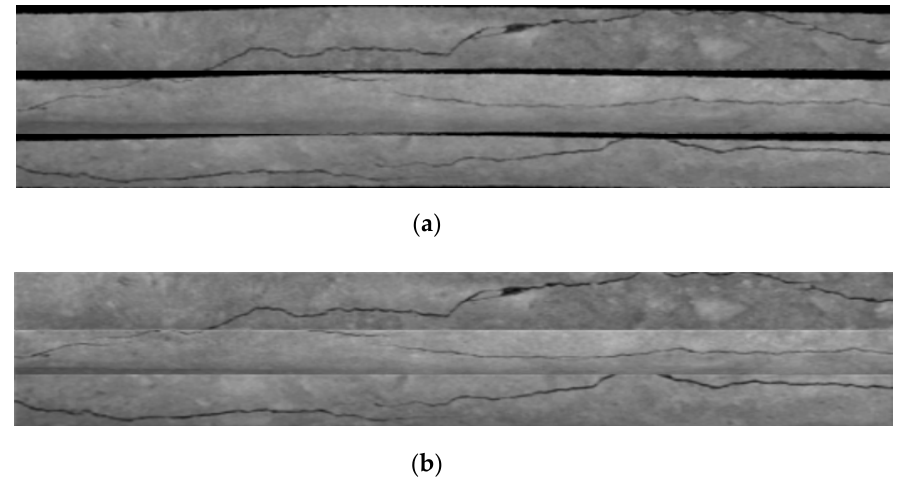
Figure 6. ( a ) Expanded image of the circular elevation. ( b ) The corresponding distortion correction image.